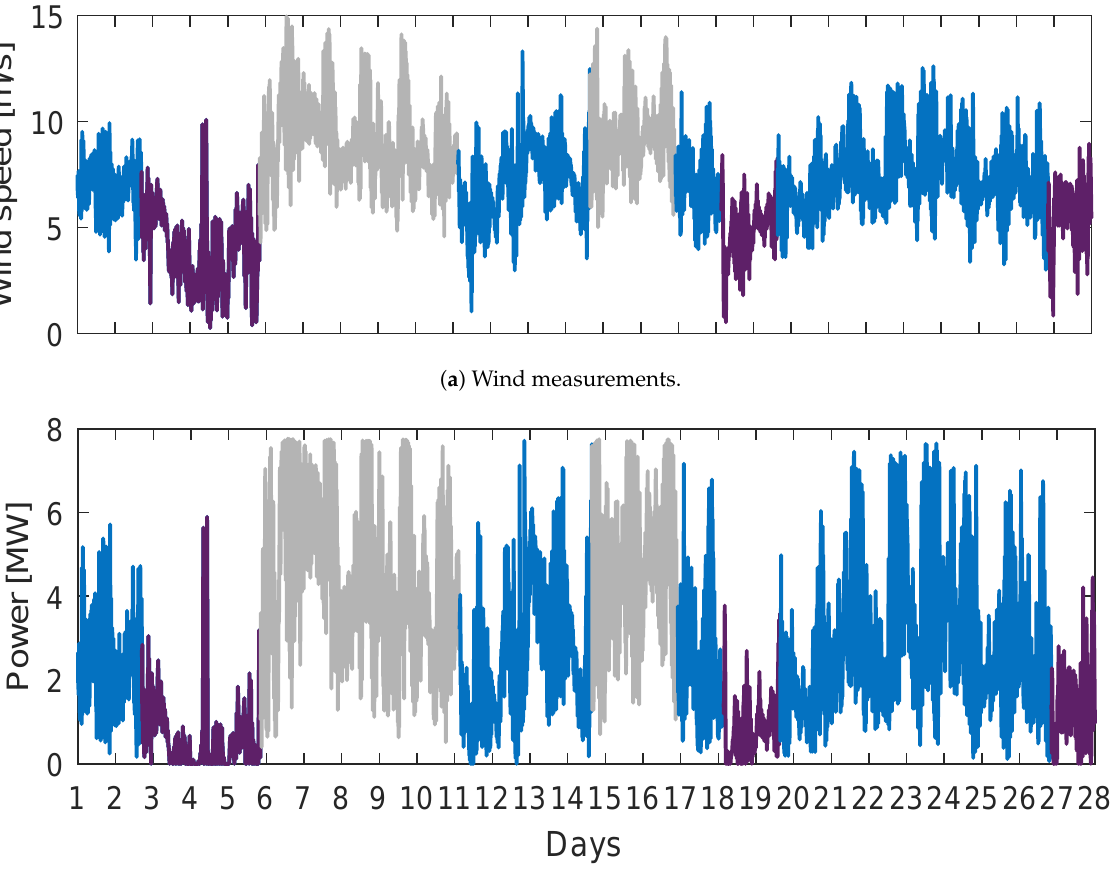
( b ) Associated power production profile. Figure 22. Wind and power profiles for 28 days.